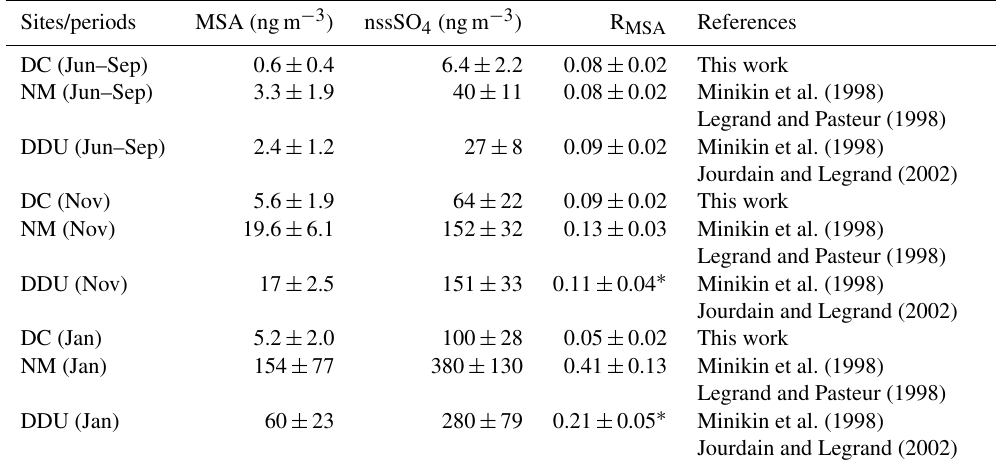
Table 1. MSA, nssSO 2 − , and MSA / nssSO 4 ratios (R MSA ) in winter (June–September), November, and January at Concordia (DC, 2006– 4 2015) and the coastal site of Neumayer (NM, 1983–1995) and Dumont d’Urville (DDU,